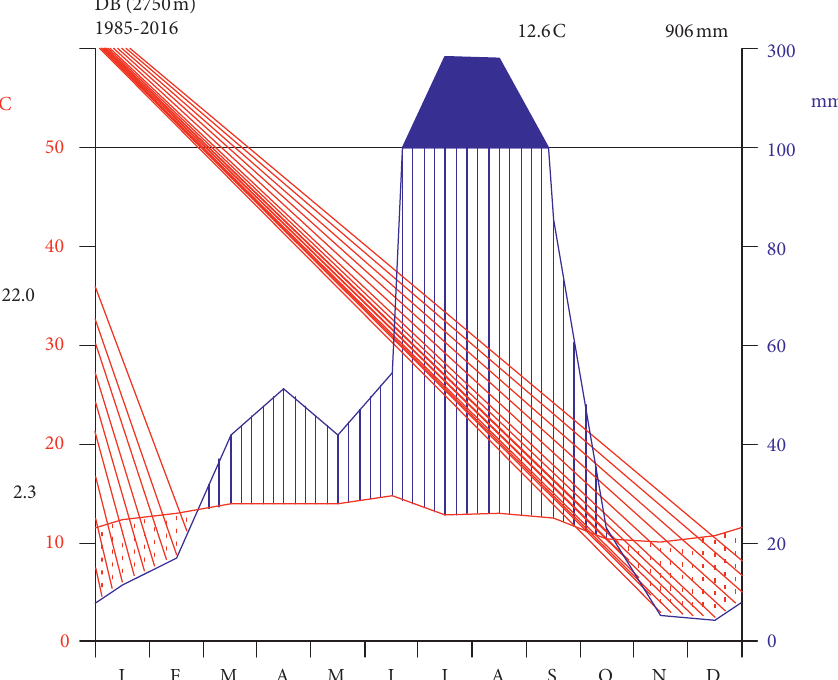
Figure 2: Climate diagram for the study area-town of Debre Berhan (DB), 2750m asl (source: ©NMA,